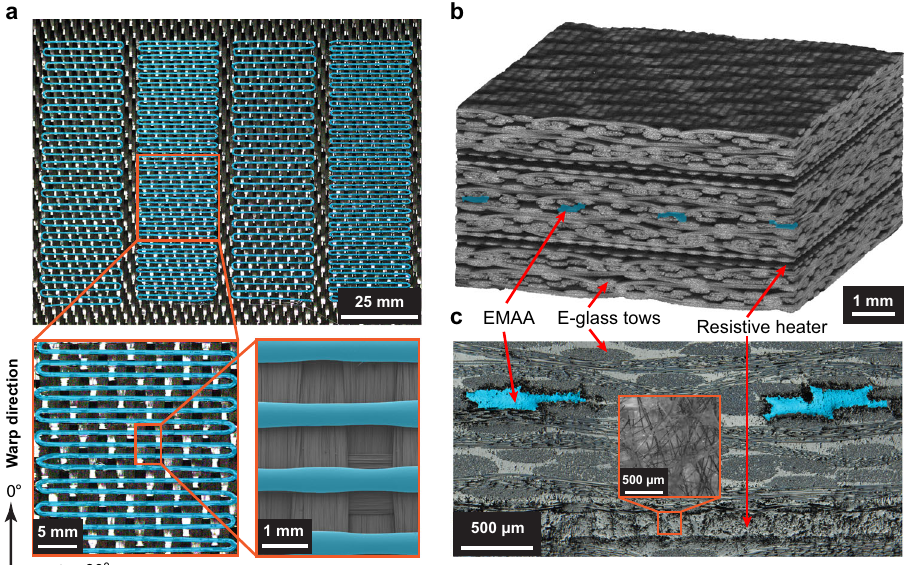
Fig. 2 | Hierarchical multifunctional composite construction. a Overhead ima- ges of 3D printed serpentine patterns of EMAA thermoplastic (blue overlay) directlyontowovencarbon- fi berreinforcementdemonstratingbothscalable(top) and precise (bottom) placement. b 3D x-ray computed microtomography ( μ